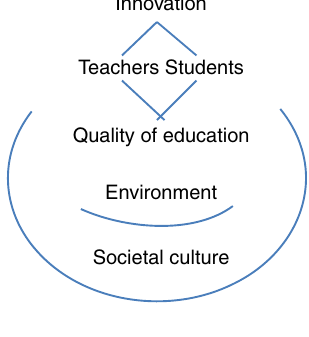
Figure 1. Model of